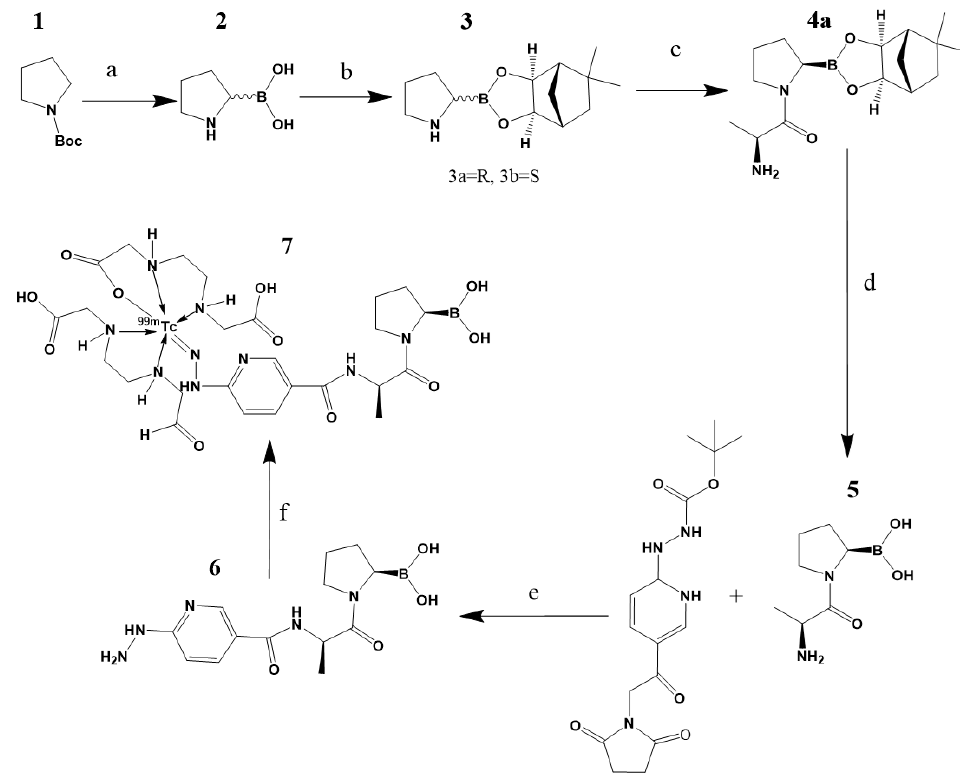
Figure 8. Reagents: ( a )(1) s-buLi, Et 2 O, TMDA, − 40 °C, 3 h, (2) B(OCH 3 ) 3 , (3) NaOH, (4) HCl; ( b )(1) (+)pinanediol, Et 2 O, 2 h; ( c ) (1) Boc-D-alanine, CH 2 CL 2 , HOBT, EDC, 30 min, 0 °C, (2) 3a, NMM, 8 h, (3) TFA, (4)H 2 O, Na 2 CO 3 , KHSO 4 ; ( d ) (1) 4a, H 2 O, (2) PhB(OH) 2 , hexane, 24 h; ( e ) (1) Succinimidyl-N-Boc-hynic, DIPEA, HATU, DMF, 15 min, (2) 5 , 2 h, (3) TFA; and ( f ) (1) EDDA/tricine (2) 6 , (3) 99m TcO 4 Na/SnCl 2 , 15 min, 92 °C; and 7 , proposed structure of the final product.